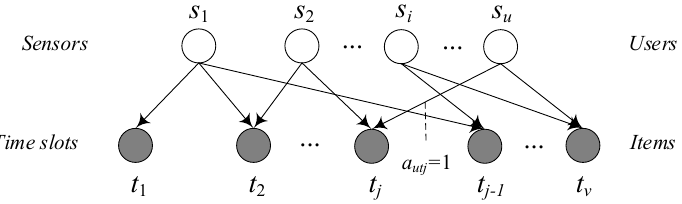
Figure7. Thebipartitegraphofsensorsandtimeslotsinmassdi ff Figure 7. The bipartite graph of sensors and time slots in mass diffusion (MD)-collaborative filtering (CF).